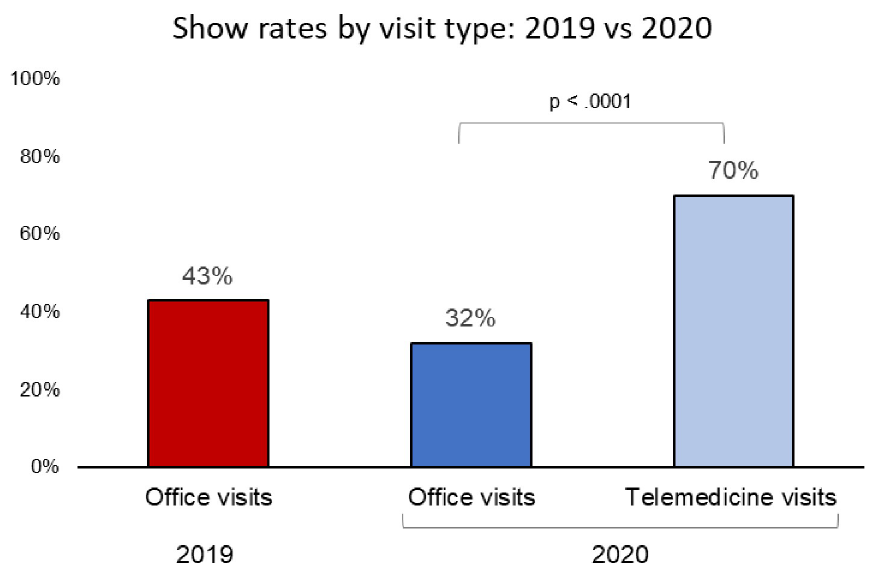
Fig 1. New patient visit completion rate by year and by visit